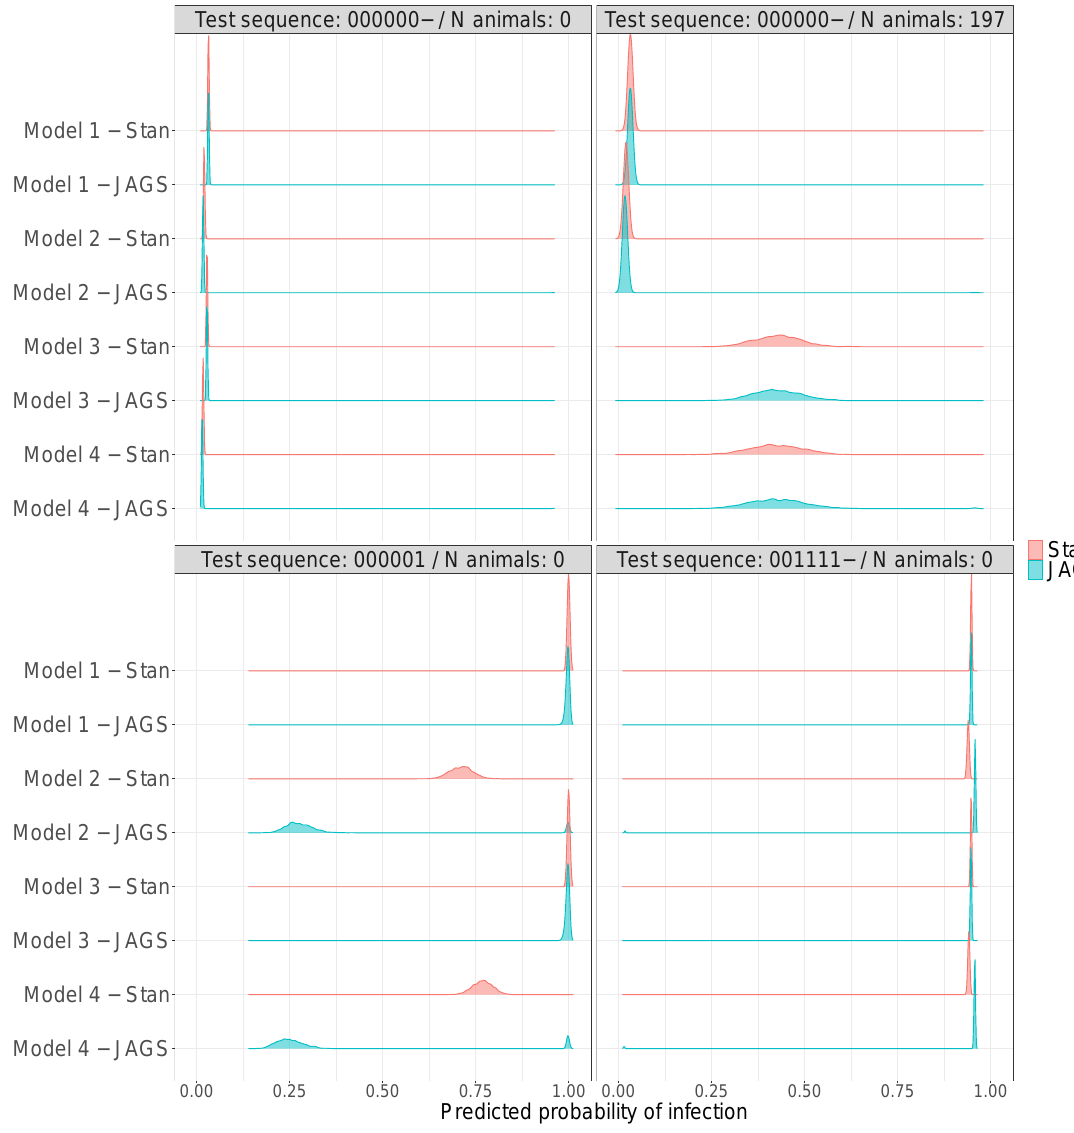
Figure 9 – Distribution of predicted probabilities of being status positive on the month of prediction for 4 herds with the 4 models compared. Model 1: Perfect test, no risk factor; Model 2: Imperfect test, no risk factor; Model 3: Perfect test, risk factor; Model 4: Imperfect test, risk factor. The title of each panel corresponds to the sequence of test results ( - indicates that a test result was available on the month before prediction), and the number of animals introduced 8 months before the month of prediction (risk